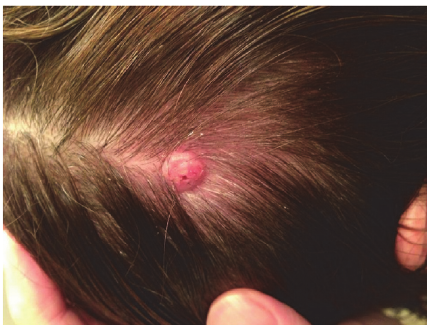
Figure 1: Nonspecific sebaceous lesion on the patient’s scalp. Lesion was excoriated and removed prior to clinical